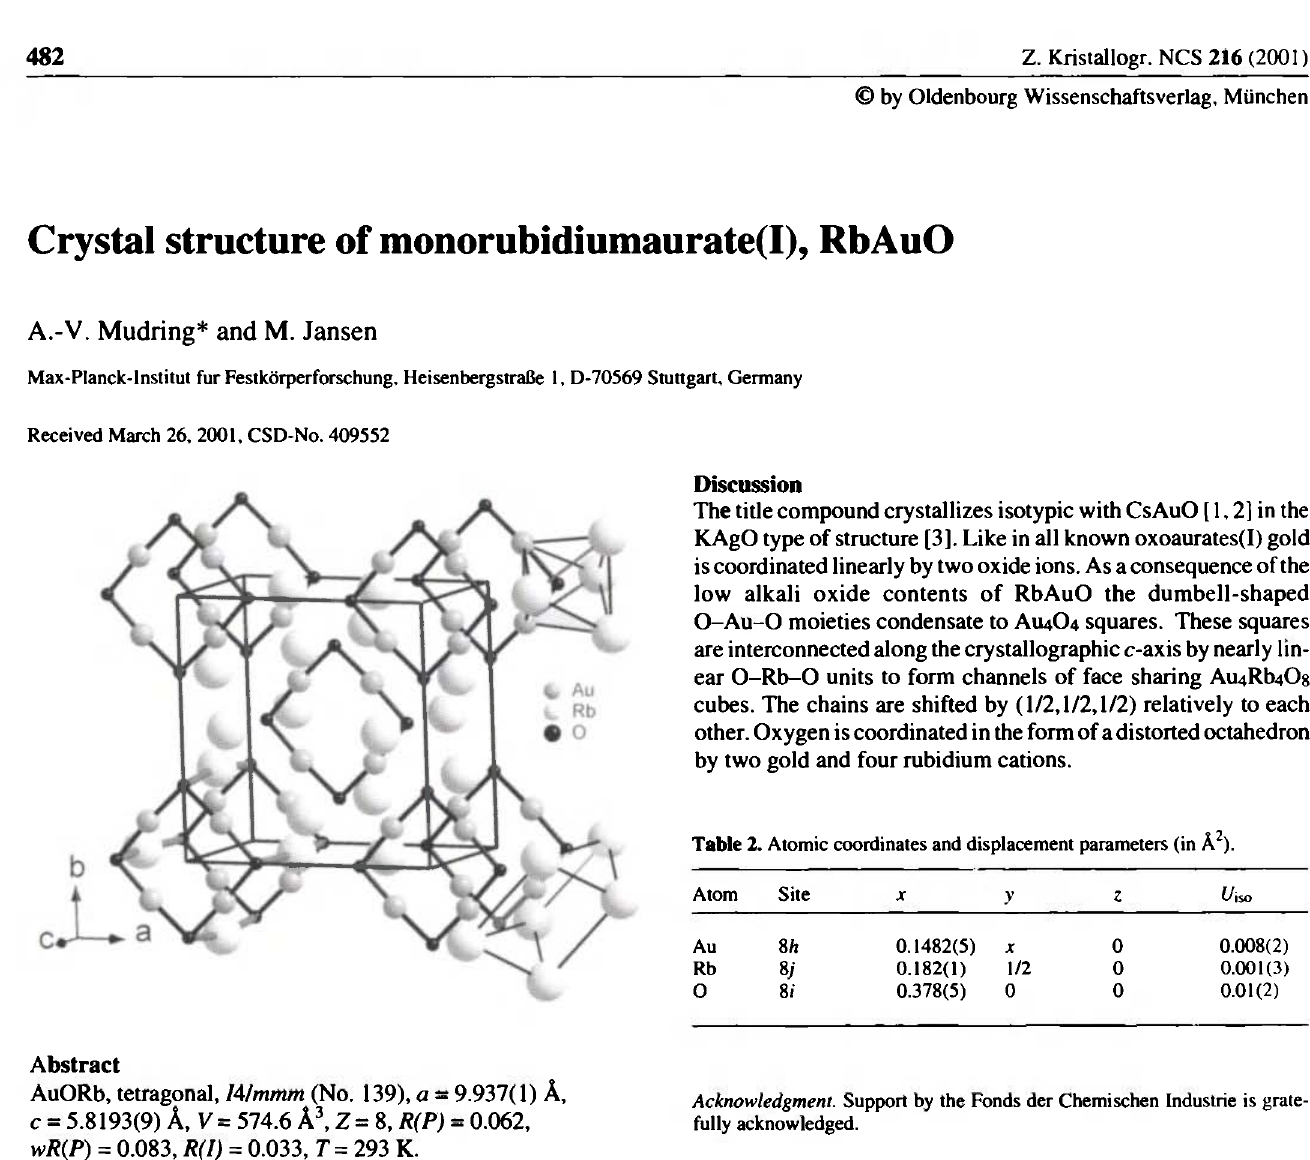
Table 1. Data collection and